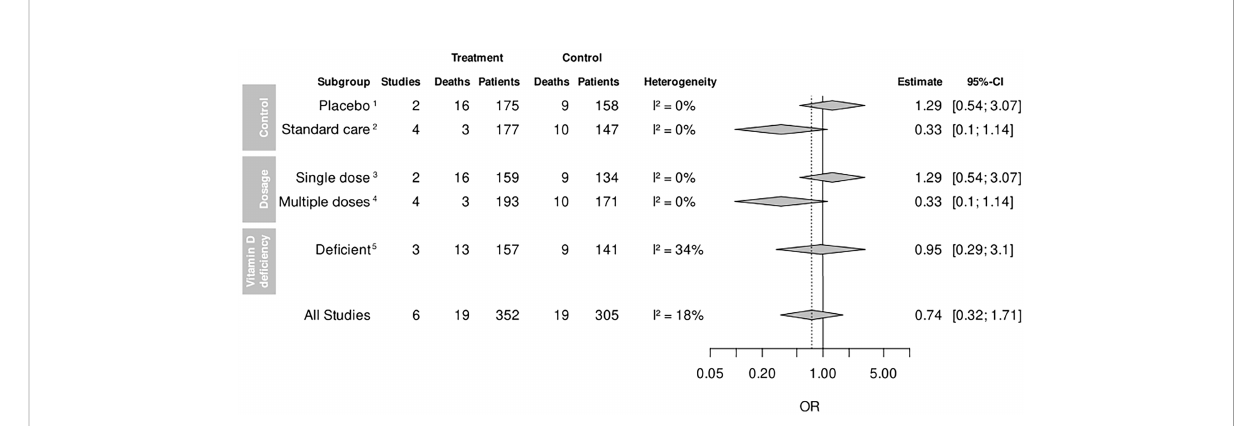
FIGURE 3 Mortality among subgroup analyses. CI, con fi dence interval; OR, odds ratio. 1 Control group receiving a placebo. 2 Control group receiving standard of care. 3 Patients receiving a single dose of vitamin D once. 4 Patients receiving more than one dose of vitamin D. 5 Patients with con fi rmed vitamin D de fi ciency below 30 or 20 ng/ml at baseline.